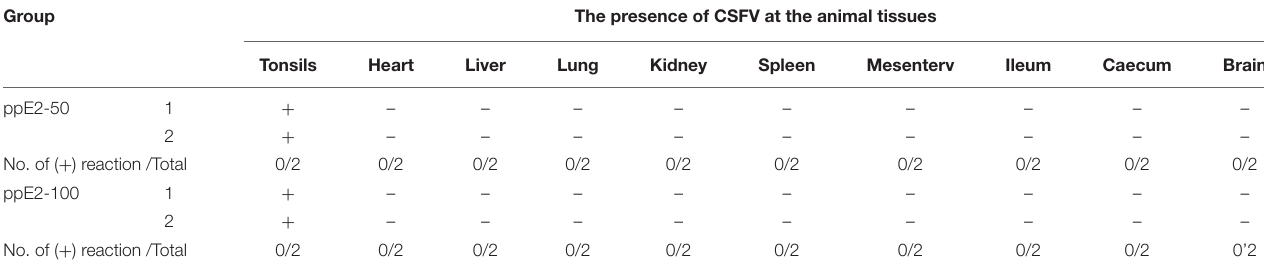
TABLE 2 | Detection of CSFV RNA in several tissues after challenge. Group The presence of CSFV at the animal